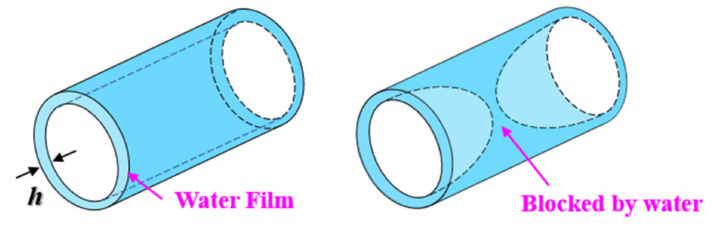
Figure 9. Effect of bound water on gas transport in circular